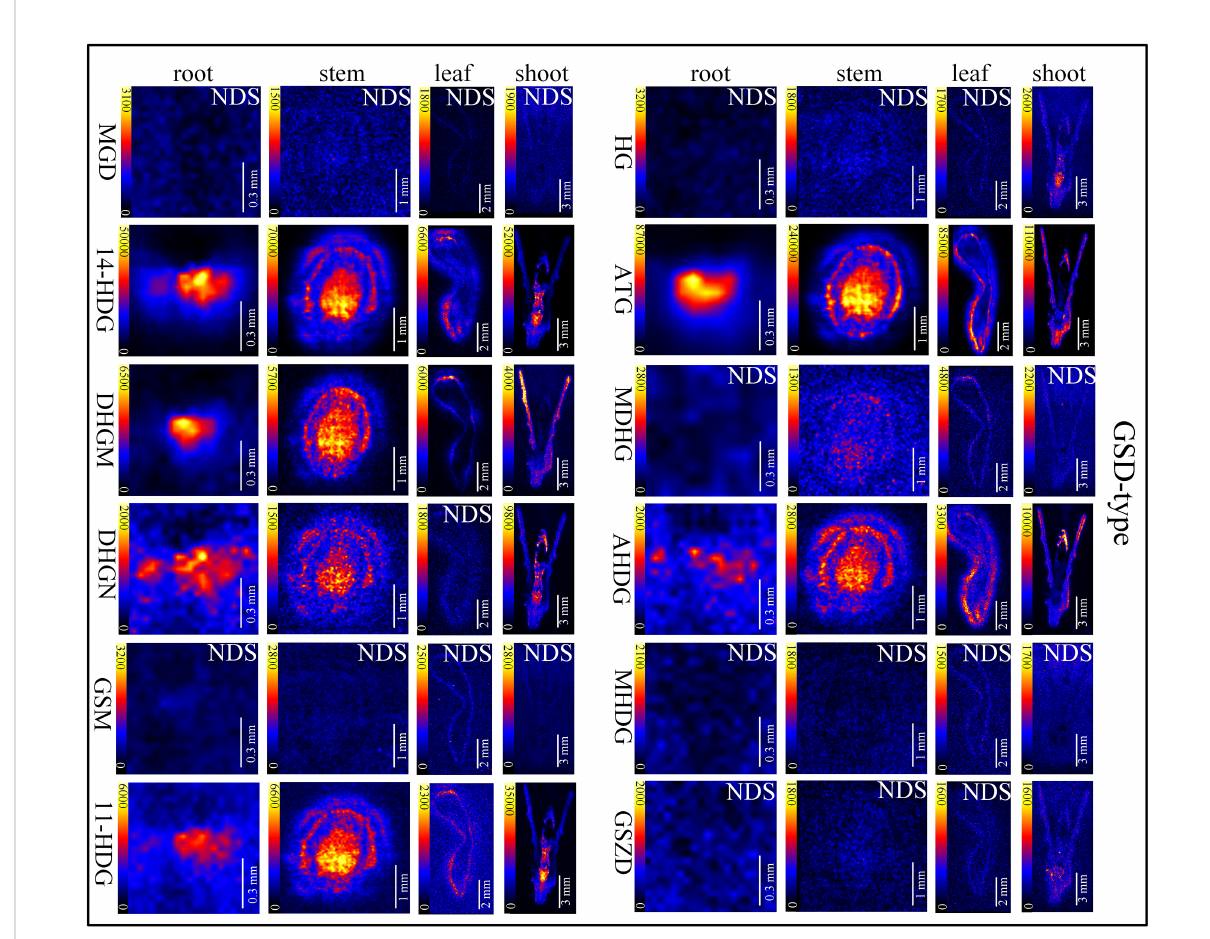
FIGURE 5 In situ visualization of gelsedine-type (GSD-type) alkaloids in different organ/tissue sections. NDS means no detectable signal. The names of the alkaloids are abbreviated. MGD, Nb-methylgelsedilam ( m/z 329.1271); 14-HDG, 14-hydroxygelsenicine ( m/z 343.1658); DHGM, 4,20- dehydrogelsemicine ( m/z 357.1814); DHGN, 11,14-dihydroxygelsenicine ( m/z 359.1607); GSM, gelsemicine ( m/z 359.1951); 11-HDG:11- hydroxygelsemicine ( m/z 373.1763); HG, hydroxylation of gelsemicine ( m/z 375.1924); ATG, 14-acetoxygelsenicine ( m/z 385.1763); MDHG, 11- methoxydihydrogelesemine ( m/z 389.2085); AHDG, 14-acetoxy-15-hydroxygelsenicine ( m/z 401.1713); MHDG, 11-methoxy-19- hydroxygelselegine ( m/z 405.2009); GSZD, gelseoxazolidinine ( m/z